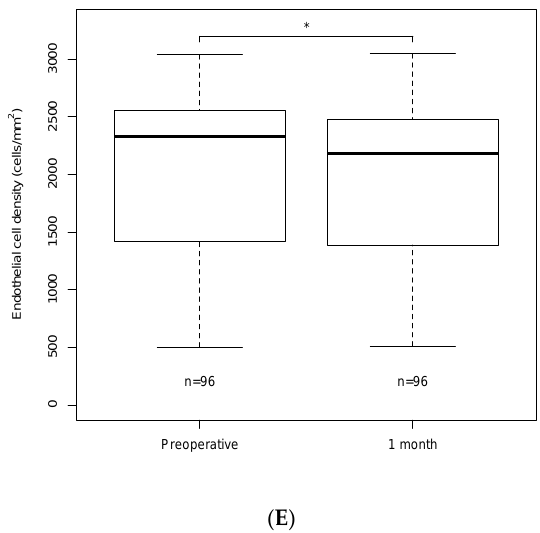
Figure 1. Box plots of each variable. ( A ) Changes in the uncorrected visual acuity (UCVA), ( B ) best-corrected visual acuity (BCVA), ( C ) spherical equivalent, ( D ) astigmatism, and ( E ) endothelial cell density. * indicates a significant difference between baseline and each time point. N.S., not significant; D, diopters; logMAR, logarithm of the minimum angle of resolution.